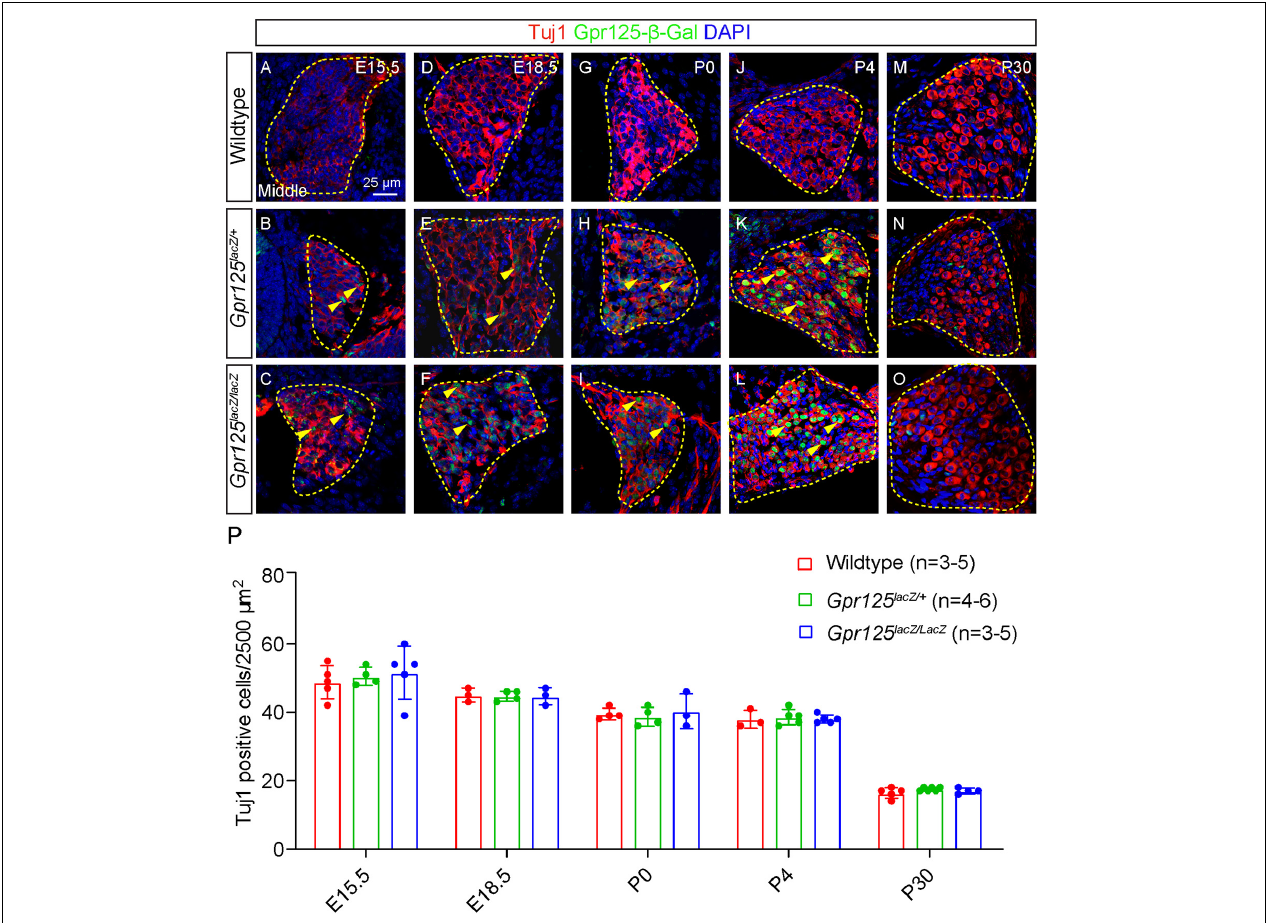
FIGURE 5 | Gpr125 deficiency does not impair spiral ganglion neuron development. Representative sections of Rosenthal’s canal from the middle turn of wild-type, Gpr125 lacZ / + , and Gpr125 lacZ / lacZ cochleae. All sections were co-stained for β -Gal (green), Tuj1 (red), and DAPI (blue). (A–I) Between E15.5 and P0, Gpr125- β -Gal expression is detected in a subset of Tuj1-positive SGNs in the Gpr125 lacZ / + and Gpr125 lacZ / lacZ cochleae (yellow arrowheads). (J–L) At P4, β -Gal expression is notably more intense in most Tuj1-positive SGNs. (M–O) At P30, Gpr125- β -Gal was undetectable in Tuj1-positive SGNs, but was noted in a few surrounding Tuj1-negative cells. Gpr125- β -Gal-positive signal was not observed in wild-type SGNs across ages. (P) Quantification of Tuj1-positive neurons showing no significant difference in counts among wild-type, Gpr125 lacZ / + , and Gpr125 lacZ / lacZ cochleae in all ages examined ( p > 0.05, one-way ANOVA). Data are presented as mean ±